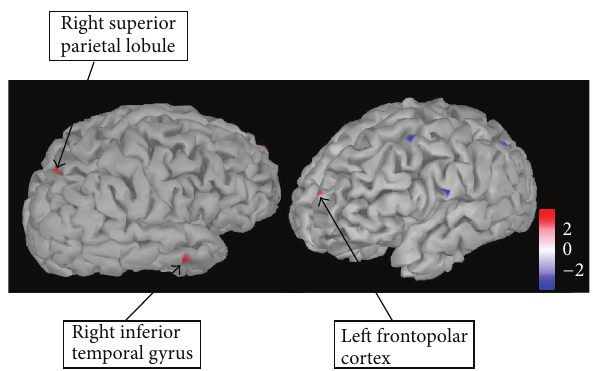
Figure 6: Regions showing significantly higher activation in the AN-R compared to HC group at 320 ms after stimulus. Regions showing significantly higher activation in a 𝑡 -test comparing the AN-R and HC group (shown in red) at 320 ms after stimulus (all food pictures versus baseline). Regions were identified by eye and are uncorrected for multiple comparisons ( 𝑝 = 0.005 ). Scale shown represents the 𝑡 -value. AN-R: recovered Anorexia Nervosa group, HC: healthy control group.